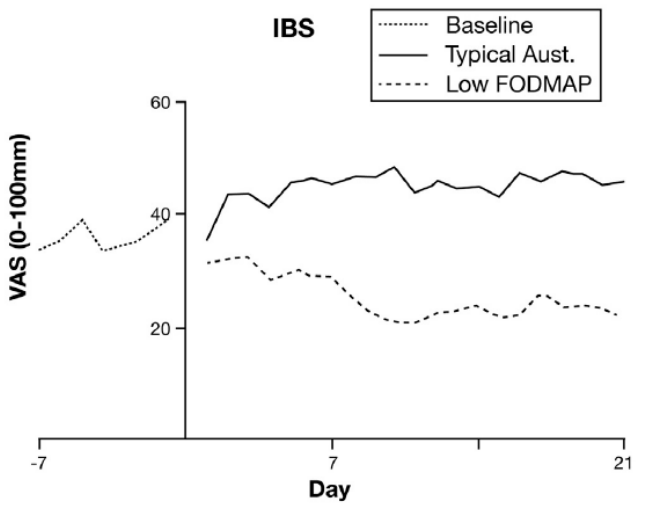
Figure 2. Mean overall gastrointestinal symptoms over time from start of either low FODMAP die or typical Australian diet high in FODMAPs. Symptom were significantly lower on the low FODMAP diet. Reproduced with permission from the Editor of Gut from Halmos et al. [92].